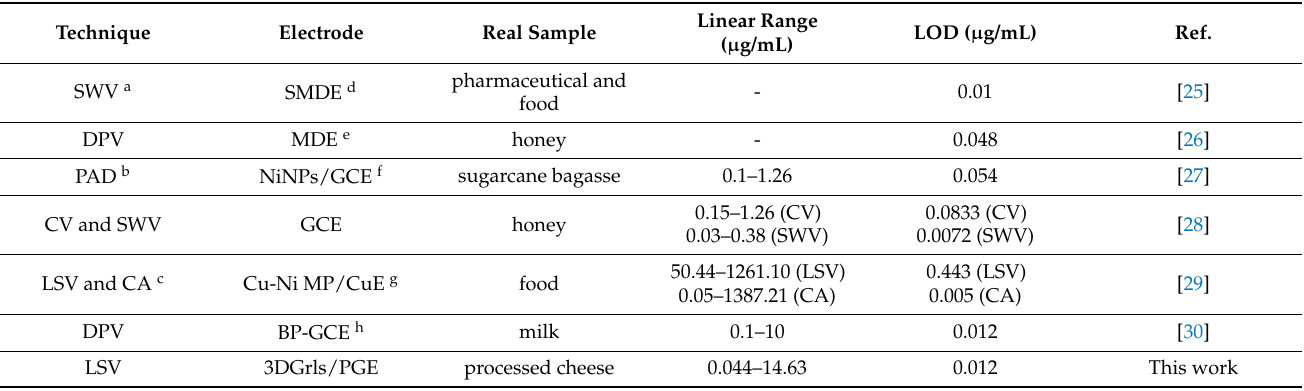
Table 1. Comparisons of the sensing performances of different electrodes for the determination of HMF.